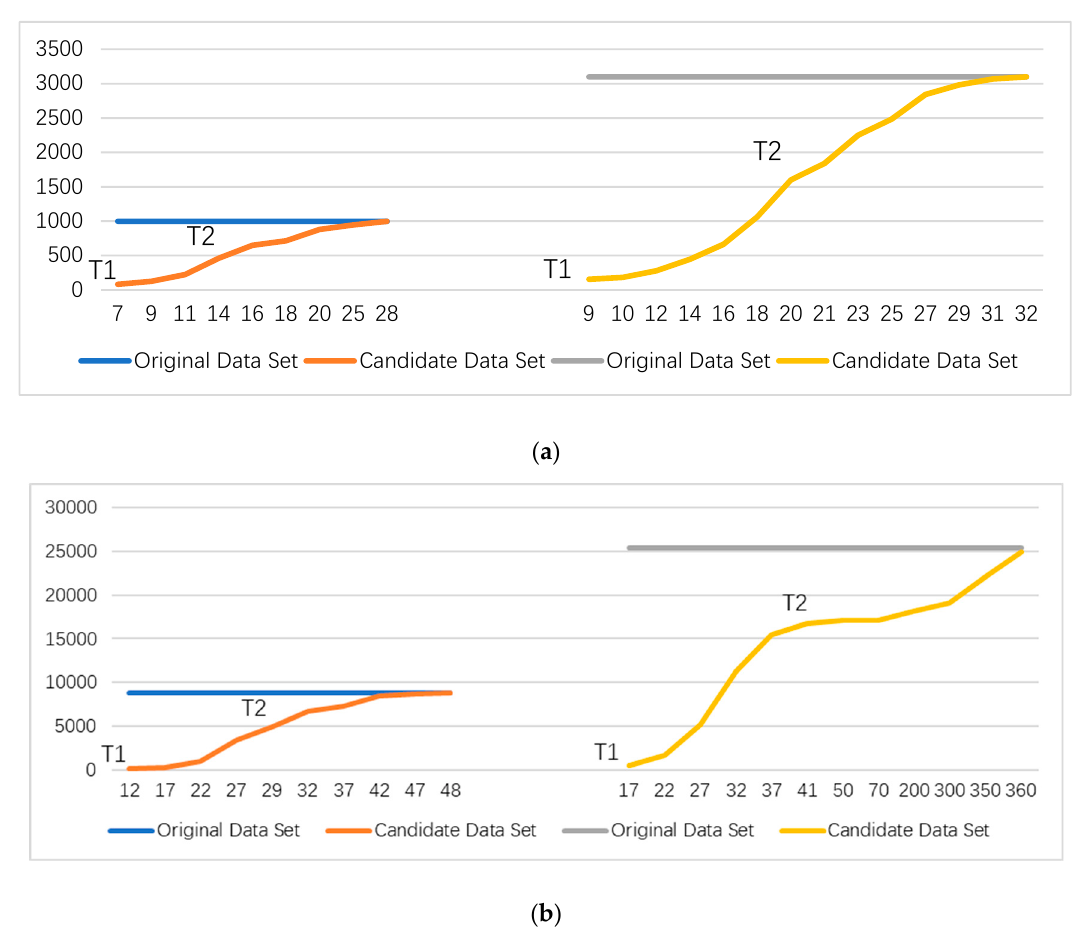
Figure 4. The effects of the size of threshold partitioning functions (T1 denotes the threshold function value is too small, and T2 is the threshold function value proposed in this paper) on candidate datasets: ( a ) describes the original datasets of |N| = 998 and |N| = 3100; ( b ) describes the original datasets of |N| = 8780 and |N| = 25,390.